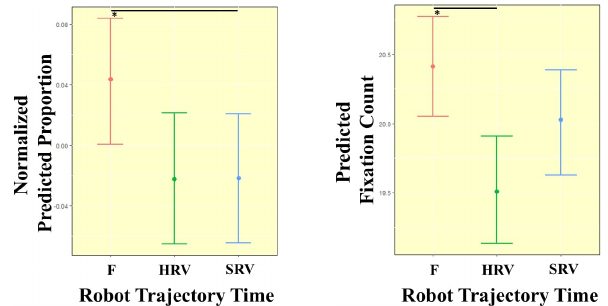
Figure6: Fixationpatternsacrossthestudy.Predictedvaluesareplot- tedonthey-axesinordertofacilitatetheinterpretationofresults.Ver- tical bars denote +/- 1 standard error. Horizontal bars denote differ- ences surviving post hoc comparison. Figure on the left shows trajec- tory Time (rTT) main effect on participants’ proportional dwell time (eye region) (F: Mean=0.82, S.D.=0.27; HRV: Mean=0.80., S.D.=0.29; SRV: Mean=0.80, S.D.=0.28). Normalized predicted values of dwell time are plotted on the y-axis in order to facilitate the interpretation of results. Figure on the right shows trajectory Time (rTT) main ef- fects on participants’ amount of fixations (F: Mean=20.41, S.D.=9.89; HRV: Mean=19.51, S.D.=10.11; SRV: Mean=20.03, S.D.=9.83). Predicted values of fixation count are plotted on the y-axis in order to facilitate the interpretation of results. Vertical bars denote +/- 1 standard error. Horizontal bars denote differences surviving post hoc